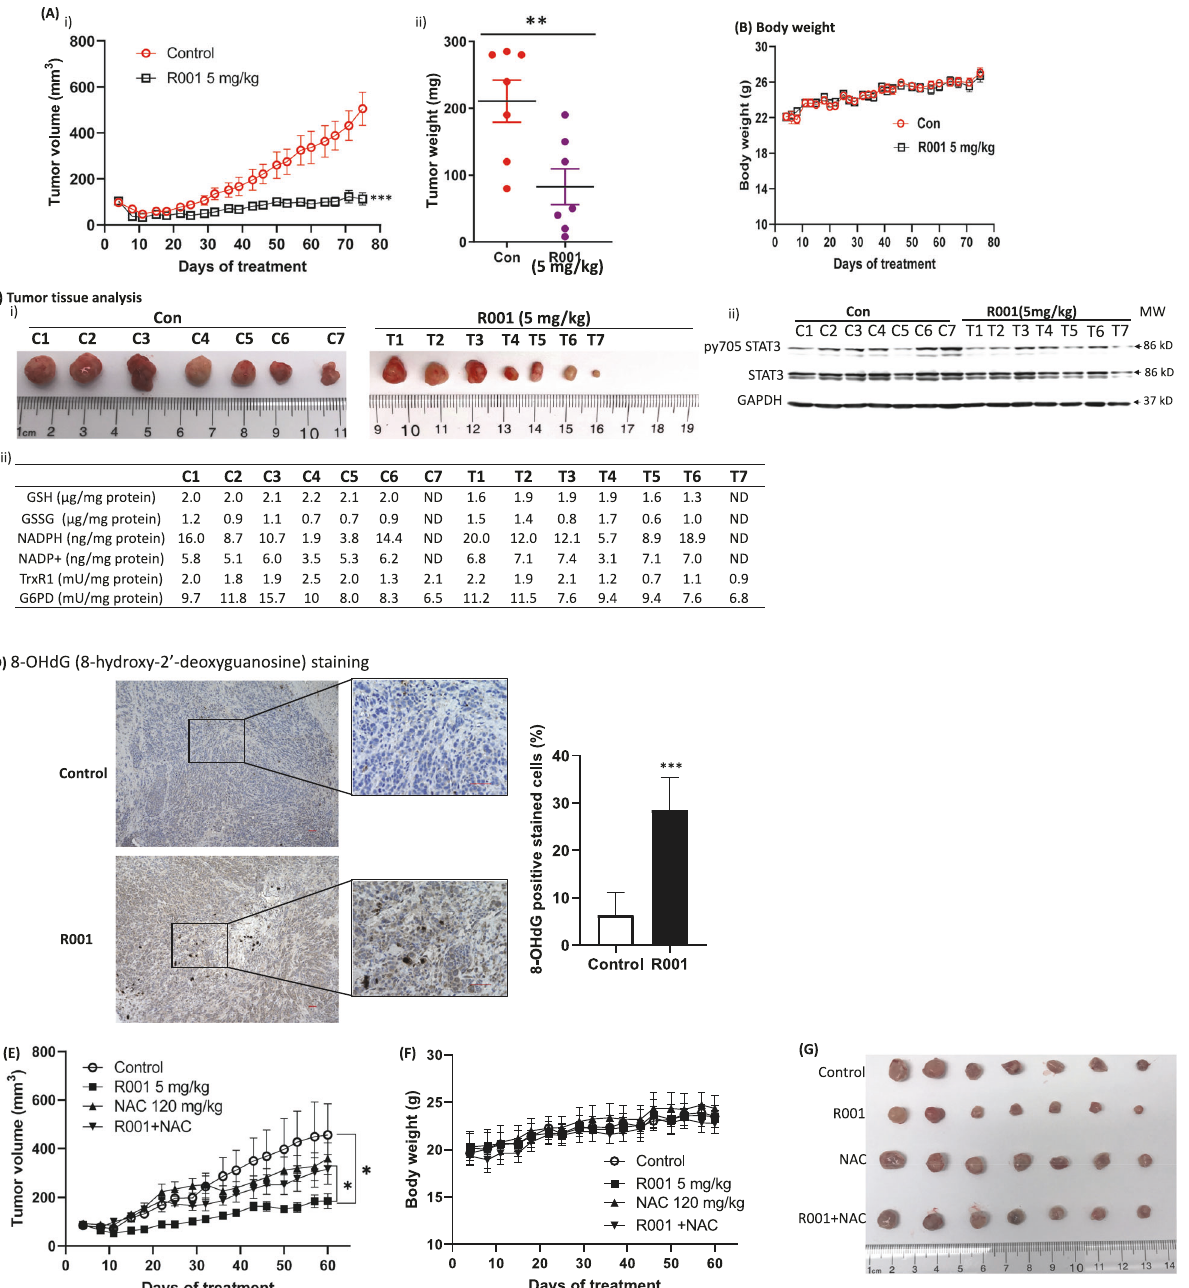
Cell Death and Disease (2022)